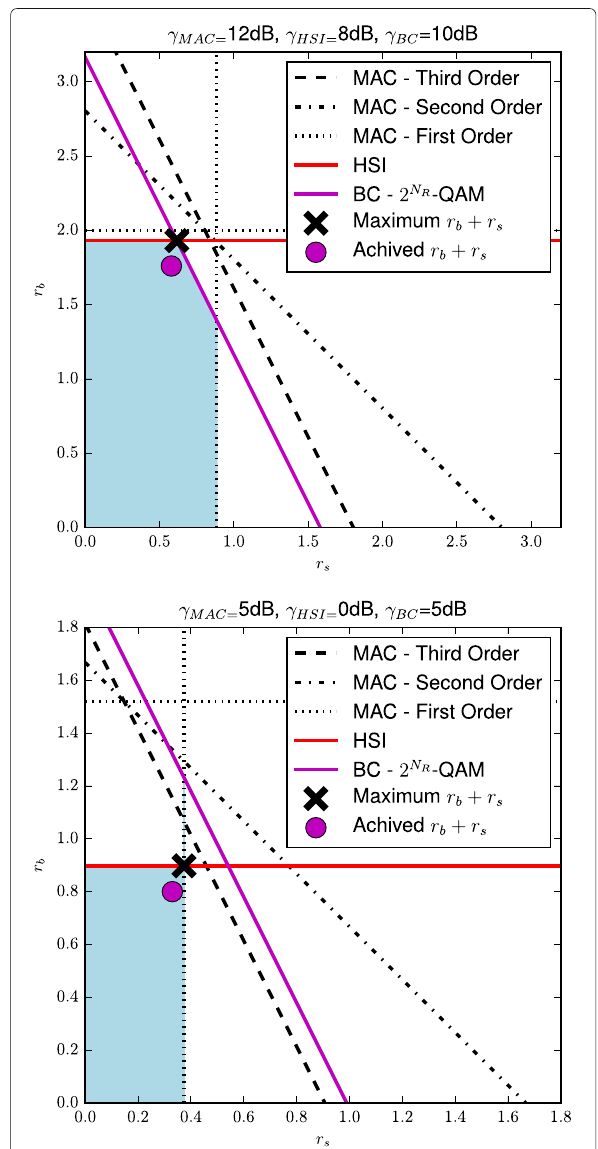
Fig. 13 Numerically evaluated cut-set bounds (mutual information for finite input constellations) for ( N b = 2, N s = 1 ) source constellations and 16-QAM at the relay. The particular SNR conditions are available in the titles of both